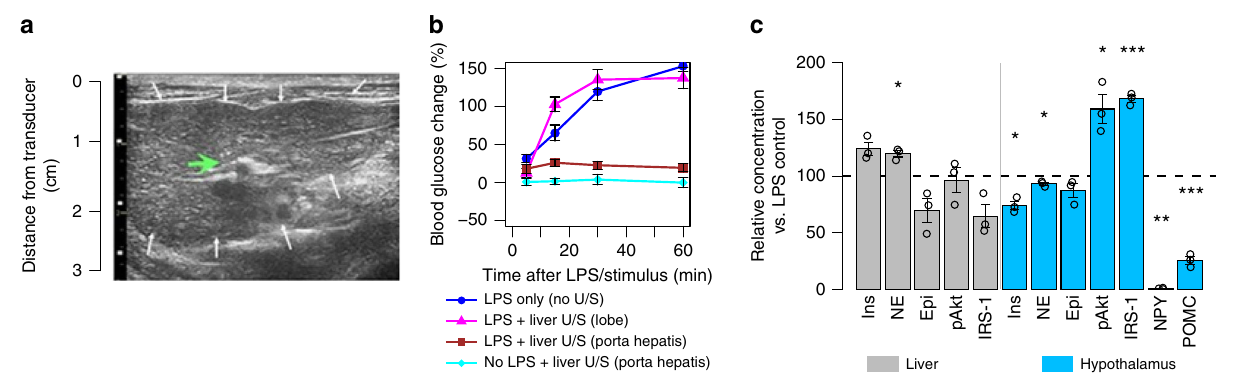
Fig. 6 Hepatic U/S stimulation of pathways that affect glucose regulation. a 2D US image of the liver used to focus the U/S stimulus to the target site (green arrow; white arrows — outline of the liver). b Data showing the effect of U/S stimulation of the liver on LPS-induced hyperglycemia. Relative blood glucose concentrations compared to pre-injection concentration are shown at times of 5, 15, 30, and 60 min. The data show reversal of LPS-induced hyperglycemia after U/S stimulation of the porta hepatis (red-squares), but not distal lobes (purple-triangles), compared to LPS alone (blue-circles) or naive/no-LPS stimulated (light blue-diamonds) samples c Relative concentrations compared to no U/S for molecules associated with metabolism in the liver and hypothalamus. Signi fi cant response to U/S stimulation was found for norepinephrine (NE), protein kinase B (pAkt), insulin receptor substrate 1 (IRS-1), and neuropeptide Y (NPY) in the hypothalamus. The asterisks mark statistical signi fi cance using two-sided t -test versus LPS only controls (with p -value thresholds; * p < 0.05, ** p < 0.01, *** p < 0.001). n = 12 for each experimental condition. All experiments in this fi gure were performed using